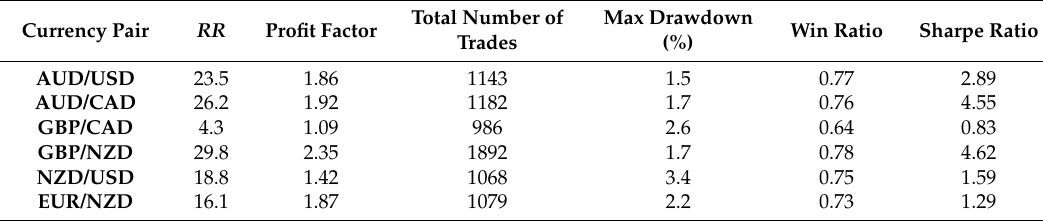
Table 7. Trading performance of IDBA following the twelve months out-of-sample period (from 1 January 2017 to 31 December 2017) of the six currency pairs.